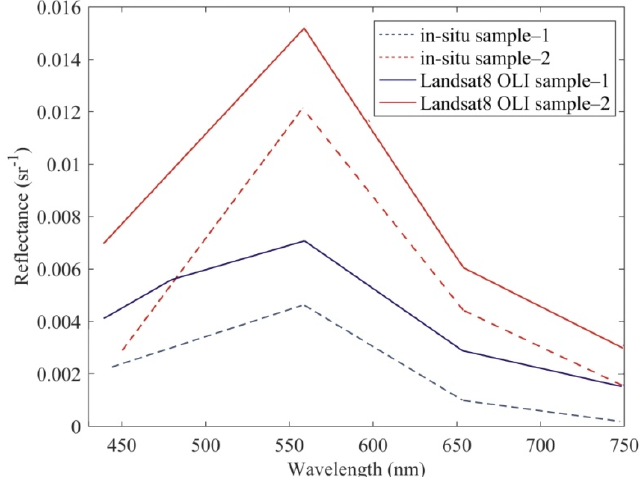
Figure 6. The comparison of reflectance from Landsat8 OLI and in situ data resampled by relative spectral respond function of Landsat8 OLI. The water constituents of sample 1 are as follows: Chl-a = 1.6ug/L and NAP = 6.6 mg/L; the water constituents of sample 2 are as follows: Chl-a = 16ug/L and NAP = 16.8 mg/L.